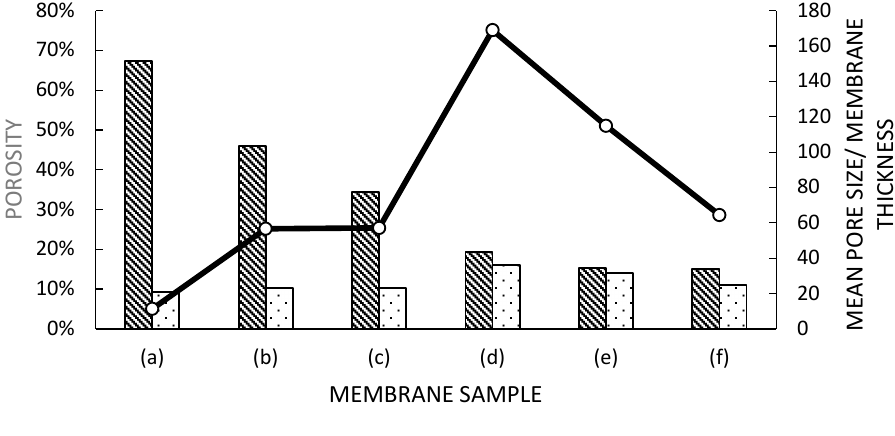
Figure 3. Comparison of porosity, thickness, and pore size of ( a ) PES 0, ( b ) PES 1, ( c ) PES 2, ( d ) PES 3, ( e ) PES 4, and ( f ) PES 5 membranes.